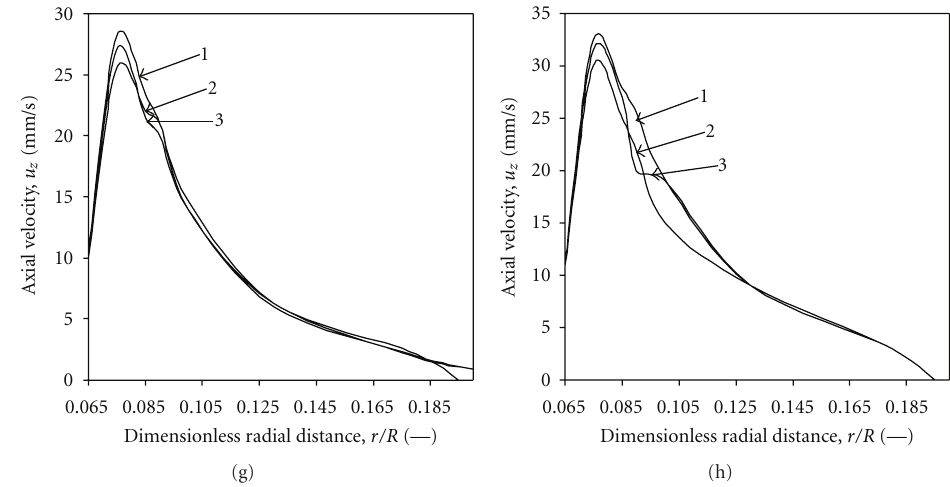
Figure 3: Variation of axial velocity with dimensionless radial distance for various grid sizes. (a) z/H = 0 . 1, (b) z/H = 0 . 33, (c) z/H = 0 . 5, and (d) z/H = 0 . 8. (e) Zoomed view of Figure 3(a), (f) Zoomed view of Figure 3(b), (g) Zoomed view of Figure 3(c), (h) Zoomed view of Figure 3(d). (1) 80 × 150, (2) 100 × 175, and (3) 100 × 200.